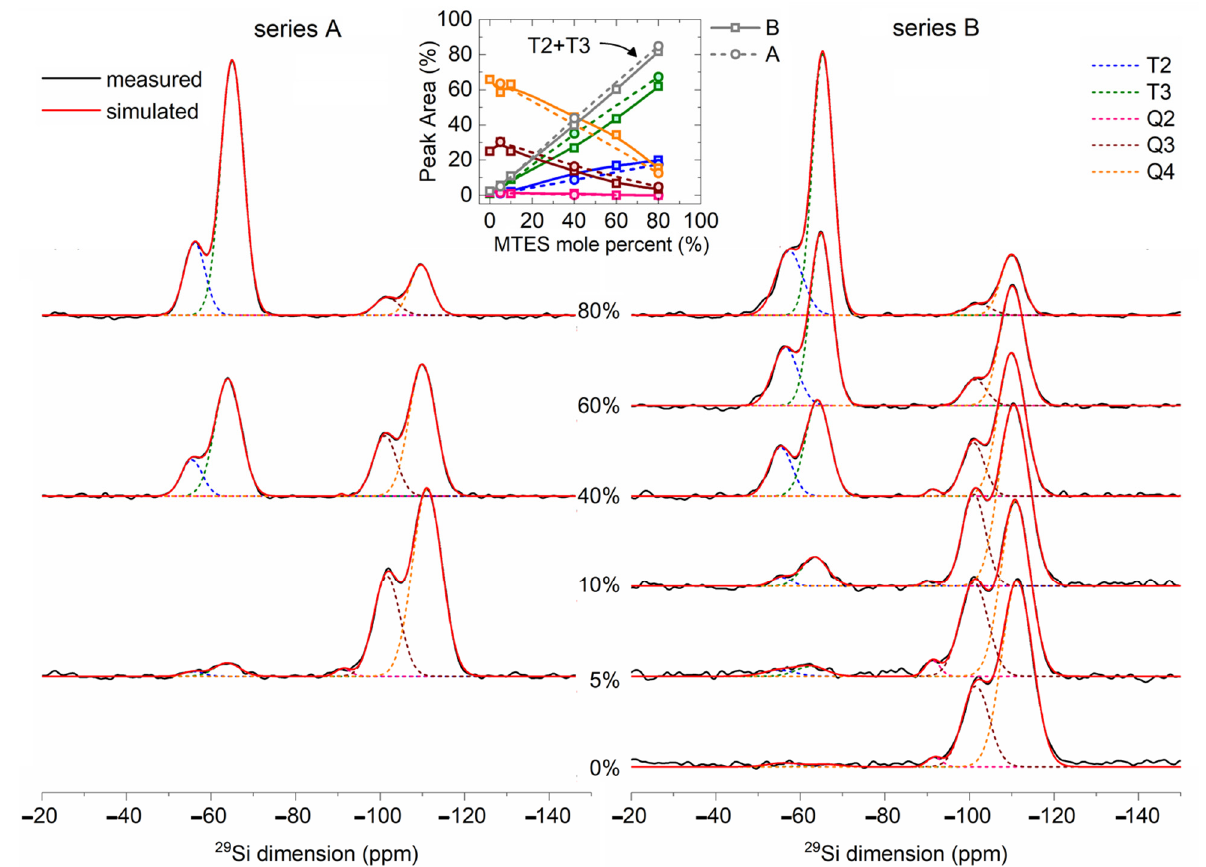
Figure 9. Solid-state 29 Si-NMR spectra of the sol–gel derived silica from different TEOS/MTES compositions (series A and series B labels represent the pH = 2.0 and pH = 4.5).